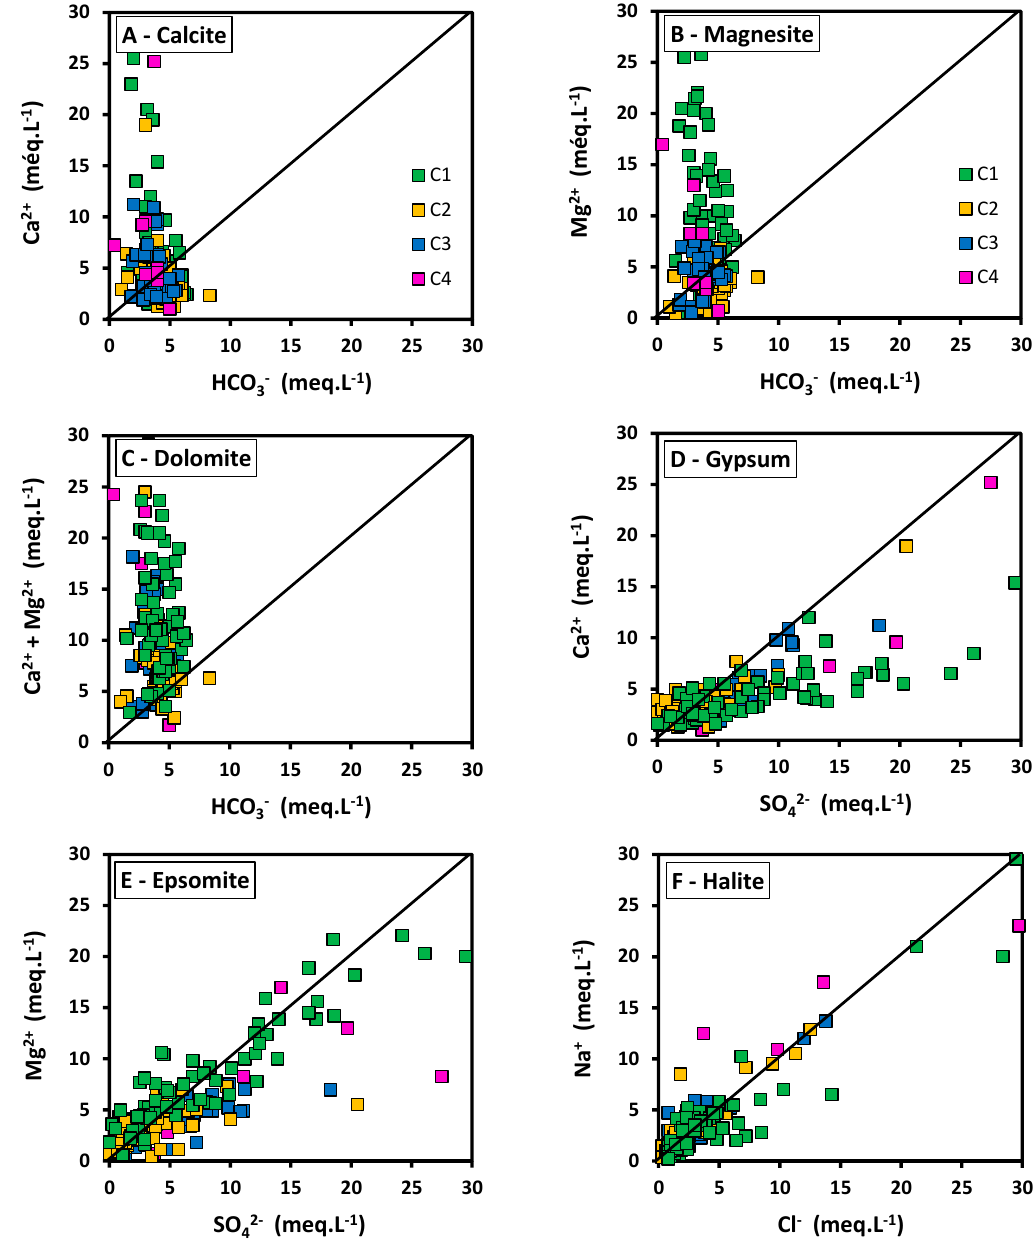
Figure 16. Bivariate plots between dissolved elements in the EUG groundwater ( A ) Calcite; ( B ) Magnesite; ( C ) Dolomite; ( D ) Gypsum; ( E ) Epsomite; ( F ) Halite.